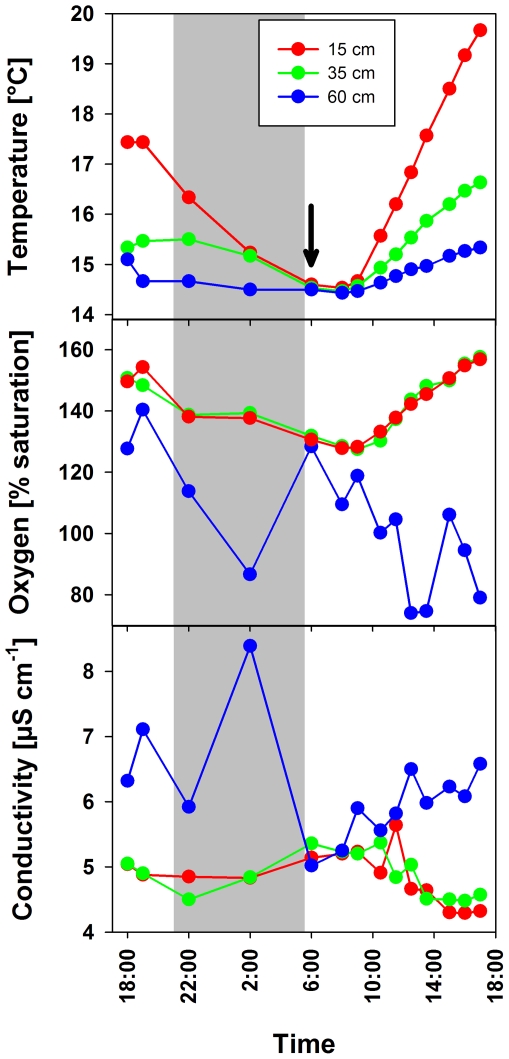
Diurnal cycles of environmental parameters in three different depths of Pond-1.Water temperature, oxygen concentration, and conductivity were measured in August 2010. The days before the recording of the diurnal cycle were characterized by cooler dull weather, while the weather conditions on the first day of measurement improved and the second day was characterized by sunny and calm weather. The arrow indicates the point in time of vertical mixing. Note that maximum temperature and oxygen values, as well as minimal conductivity values measured during the diurnal cycle were recorded in late afternoon. Since the routine sampling of the pond (Fig. 2) always took place during late-morning hours, the widths of annual variation of environmental parameters were most likely underestimated.